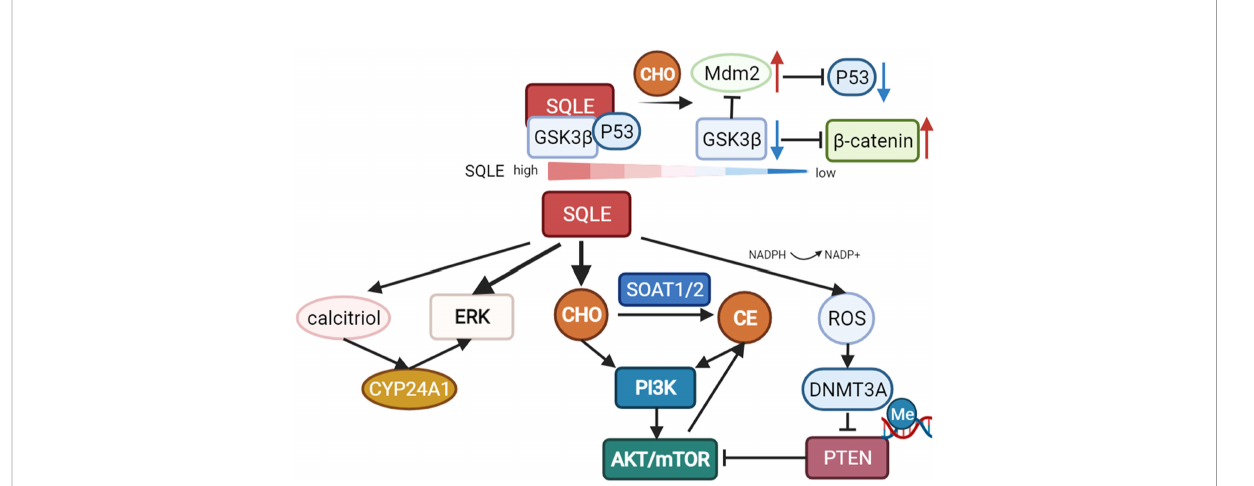
FIGURE 3 Pathways regulated by SQLE. SQLE can activate multiple oncogenic pathways, such as PI3K/AKT/mTOR signaling and the ERK pathway, via cholesterol/cholesteryl ester accumulation. Knockdown of SQLE can also reduce calcitriol, the active metabolite of VitD3, leading to a reduction in cytochrome P450 family 24 subfamily A member 1 (CYP24A1) levels, which suppresses the phosphorylation and activation of ERK. The exhaustion of NADPH during the conversion of squalene to 2,3-epoxysqualene by SQLE can induce oxidative stress and subsequently activate DNA methyltransferase 3A (DNMT3A), leading to the epigenetic silencing of PTEN. Loss of PTEN activates AKT/mTOR pathways, contributing to SOAT-mediated cholesteryl ester accumulation and NAFLD-induced HCC. However, there is also a report that depletion of SQLE can dissociate GSK3 b and p53 and upregulate Mdm2, promoting the degradation of p53 and activation of b -catenin in colorectal cancer.